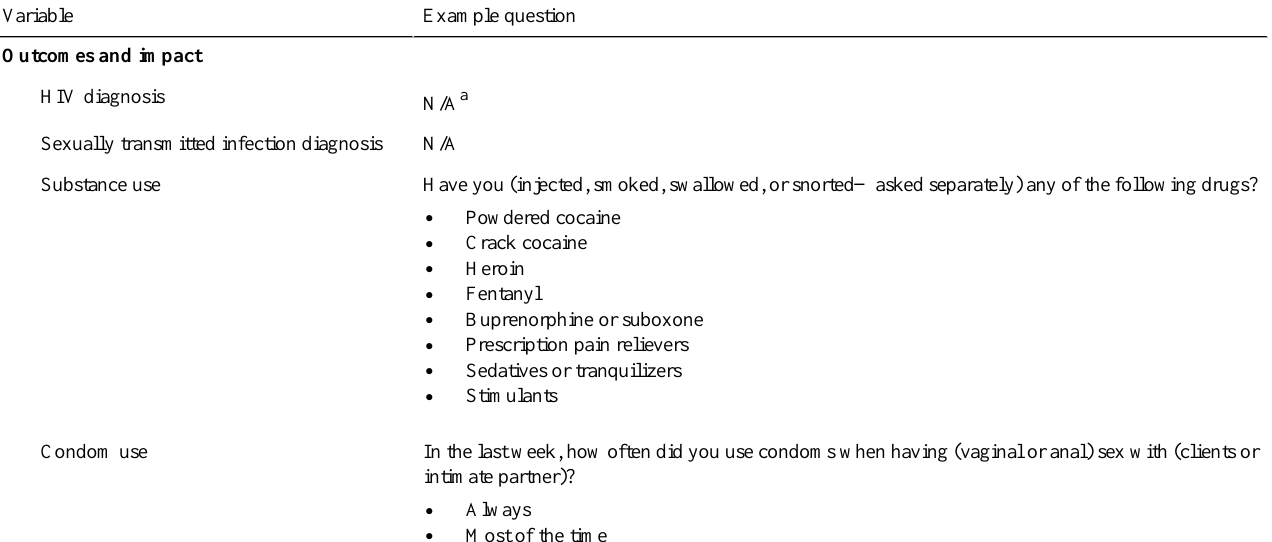
Table 1. Variables reflected in the conceptual framework and collected as part of the EMERALD (Enabling Mobilization, Empowerment, Risk Reduction, and Lasting Dignity) study of female sex workers in Baltimore,